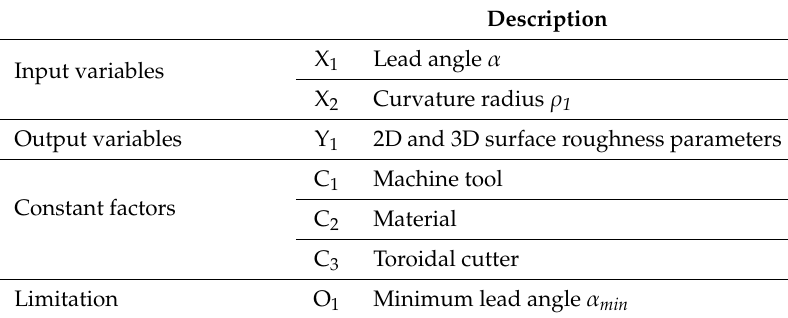
Table 3. Dimensions characteristic for the test